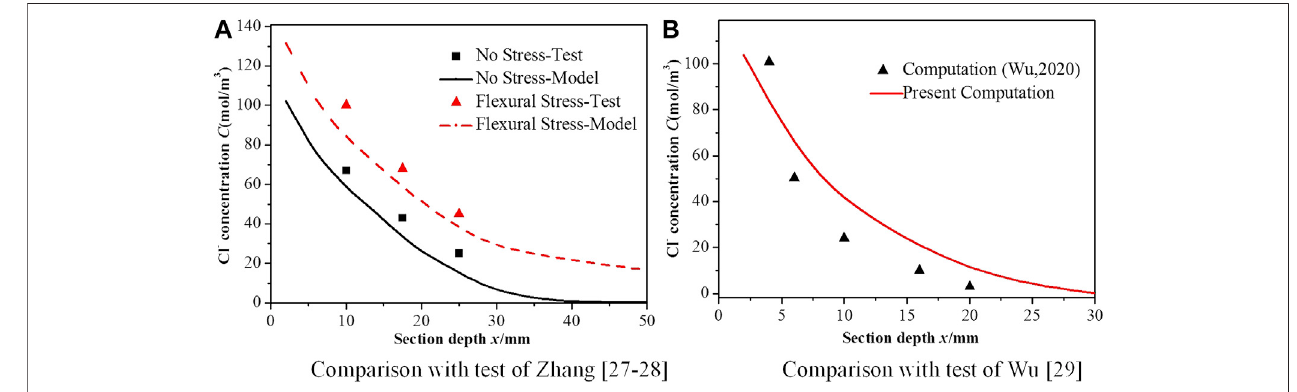
FIGURE 10 | Experimental veri fi cation of 2D diffusion variable coef fi cient of